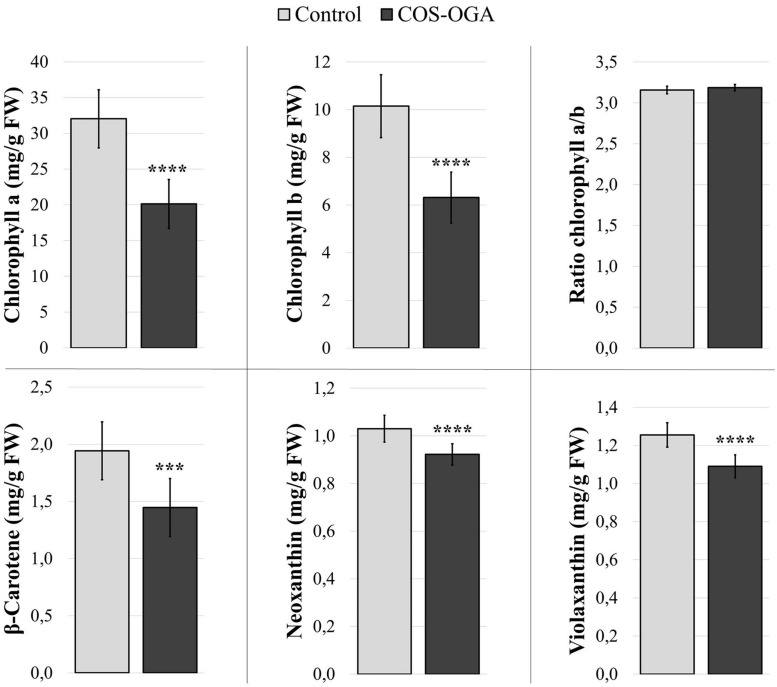
Pigment contents of tomato leaves after three sprayings with chitooligosaccharides–oligogalacturonides (COS-OGA; 62.5 mg/l). Tomato leaves were harvested 24 h after the third treatment. The average pigment contents are expressed as mg/g fresh weigh ± standard deviation (n = 12). *** and **** indicate statistically significant differences to the control group with p < 0.001 and p < 0.0001, respectively, (Wilcoxon test, R).